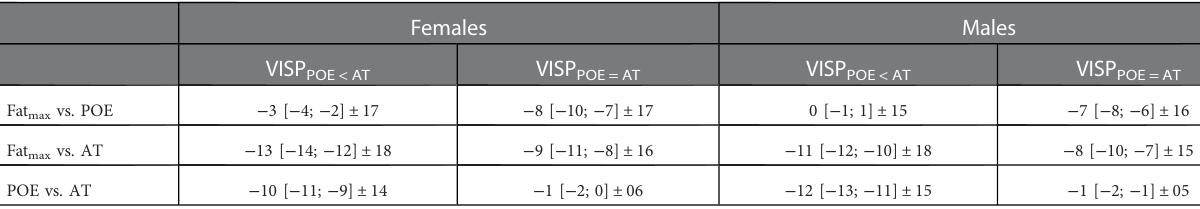
TABLE 5 Bland-Altman analysis. Comparison of the relative oxygen uptake (in terms of %VO2 peak ) between the ventilatory indices Fat max , POE and AT in VISP POE<AT and VISP POE=AT participants, separately for females and males. Females Males VISP VISP VISP VISP POE<AT POE=AT POE<AT POE=AT Fat max vs. POE − 3 [ − 4; − 2]±17 − 8 [ − 10; − 7]±17 0 [ − 1; 1]±15 − 7 [ − 8; − 6]±16 Fat max vs. AT − 13 [ − 14; − 12]±18 − 9 [ − 11; − 8]±16 − 11 [ − 12; − 10]±18 − 8 [ − 10; − 7]±15 POE vs. AT − 10 [ − 11; − 9]±14 Data are presented as mean bias [95% con fi dence interval]±95% limits of